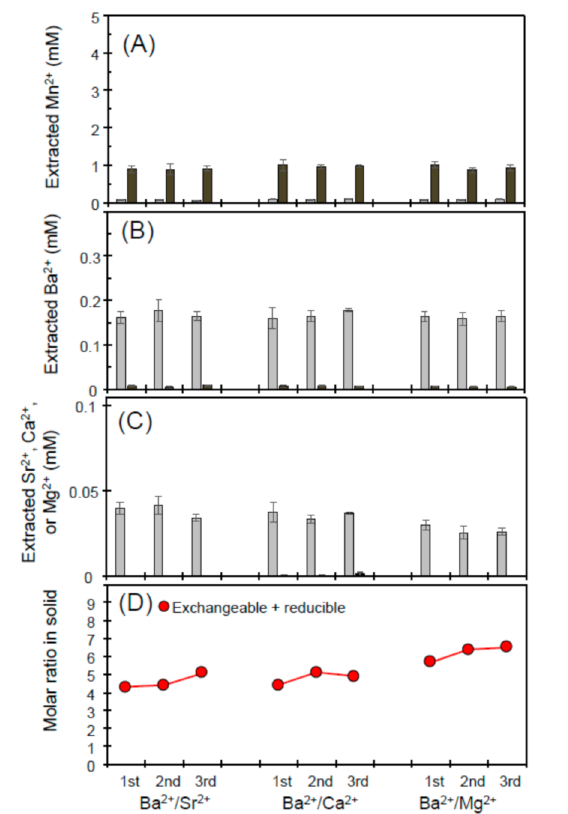
Figure 9. Diagram showing the two-step extraction of ( A ) Mn; ( B ) Ba; and ( C ) Sr, Ca, or Mg from the newly formed biogenic manganese oxides during repeated treatment with mixtures of 1 mM Ba(NO 3 ) 2 and 1 mM Sr(NO 3 ) 2 , Ca(NO 3 ) 2 , or Mg(NO 3 ) 2 in 20 mM HEPES (pH of 7.0) without exogenous Mn 2+ . The bathing solutions were renewed thrice every 24 h. ( D ) Plot of the Ba/Sr, Ba/Ca, and Ba/Sr molar ratios in the exchangeable and solid (exchangeable + reducible) phases showing sequestration